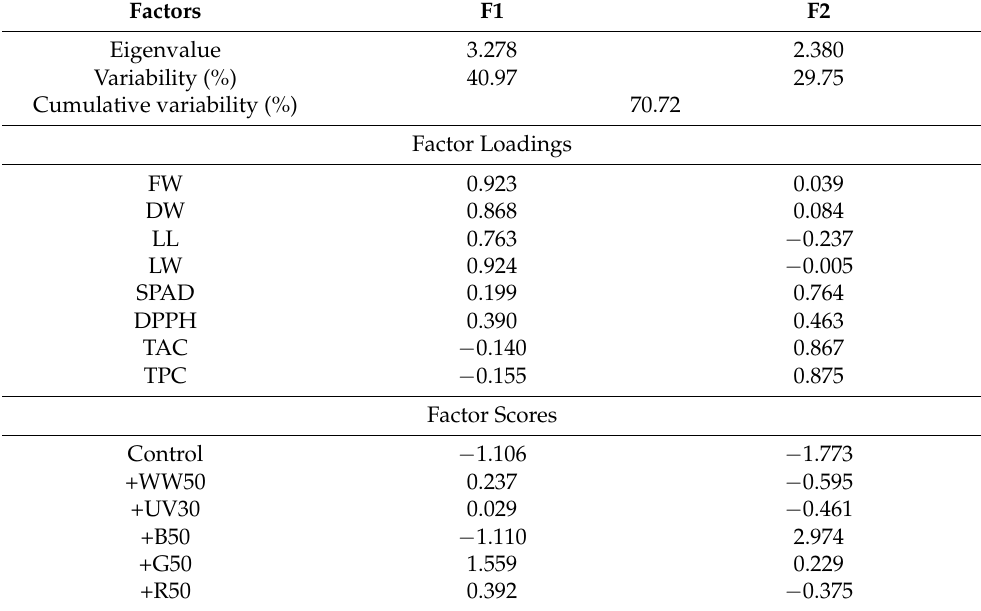
Table 1. Factor loadings, eigenvalues, variability (%), cumulative variability (%), and scores for the first two principal (F1–F2) components for growth, morphological, and biochemical measurements of ‘Rouxai’ baby-leaf lettuce grown under six different lighting treatments on harvest day.